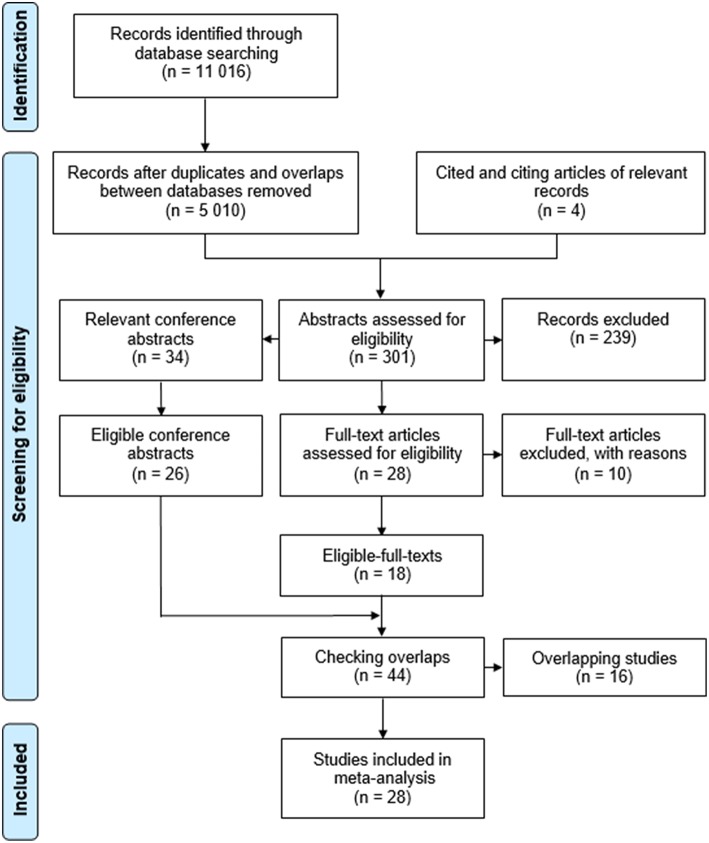
Flowchart of the meta-analysis.